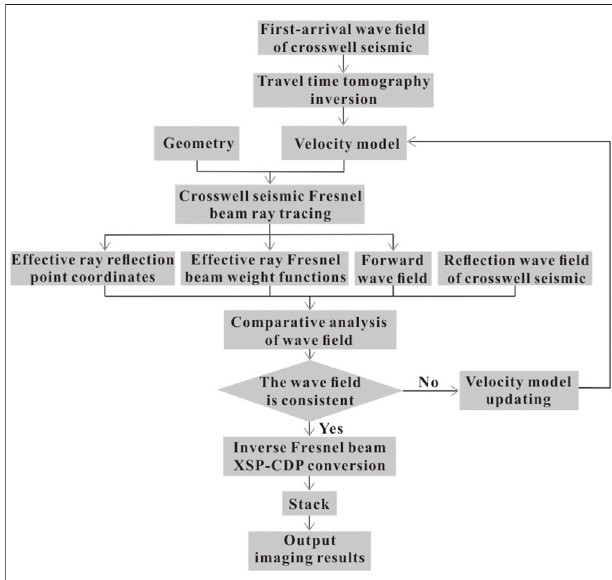
FIGURE 4 | Work fl ow of the inverse Fresnel beam XSP-CDP stack imaging